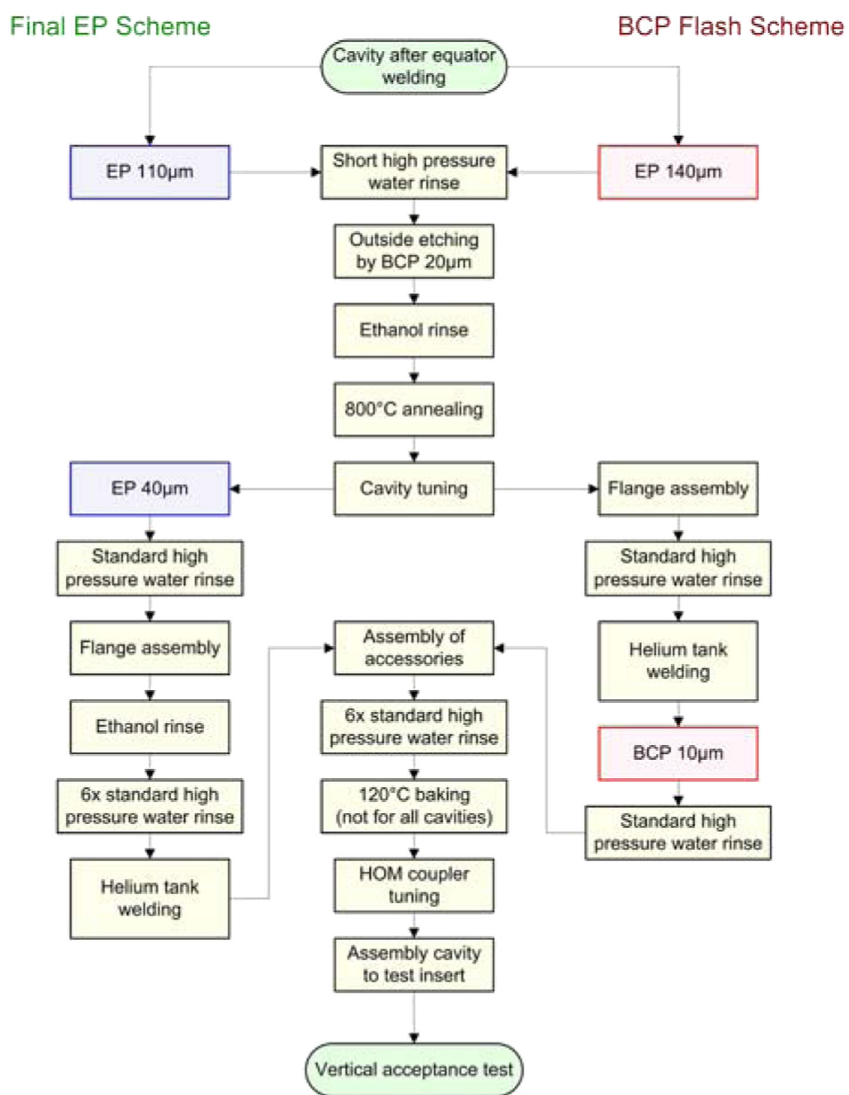
FIG. 1. (Color) Work flow diagram of the optimized preparation cycle for vertical rf acceptance test with He tank